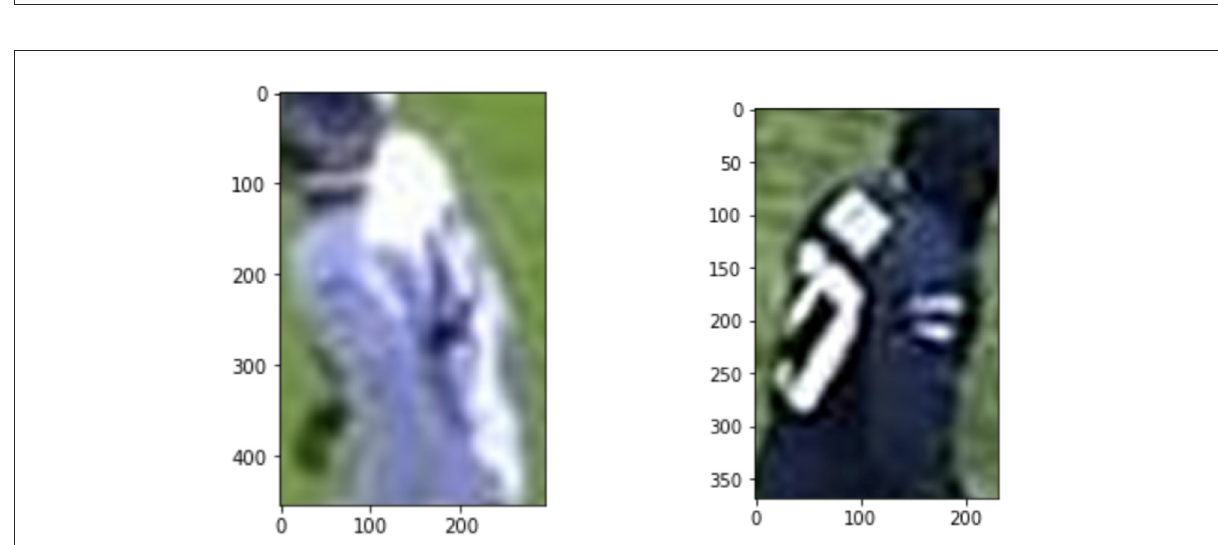
FIGURE9 Image where multi-class predicted class 100. Confusion for the multi-class model arise when the numbers are rotated or